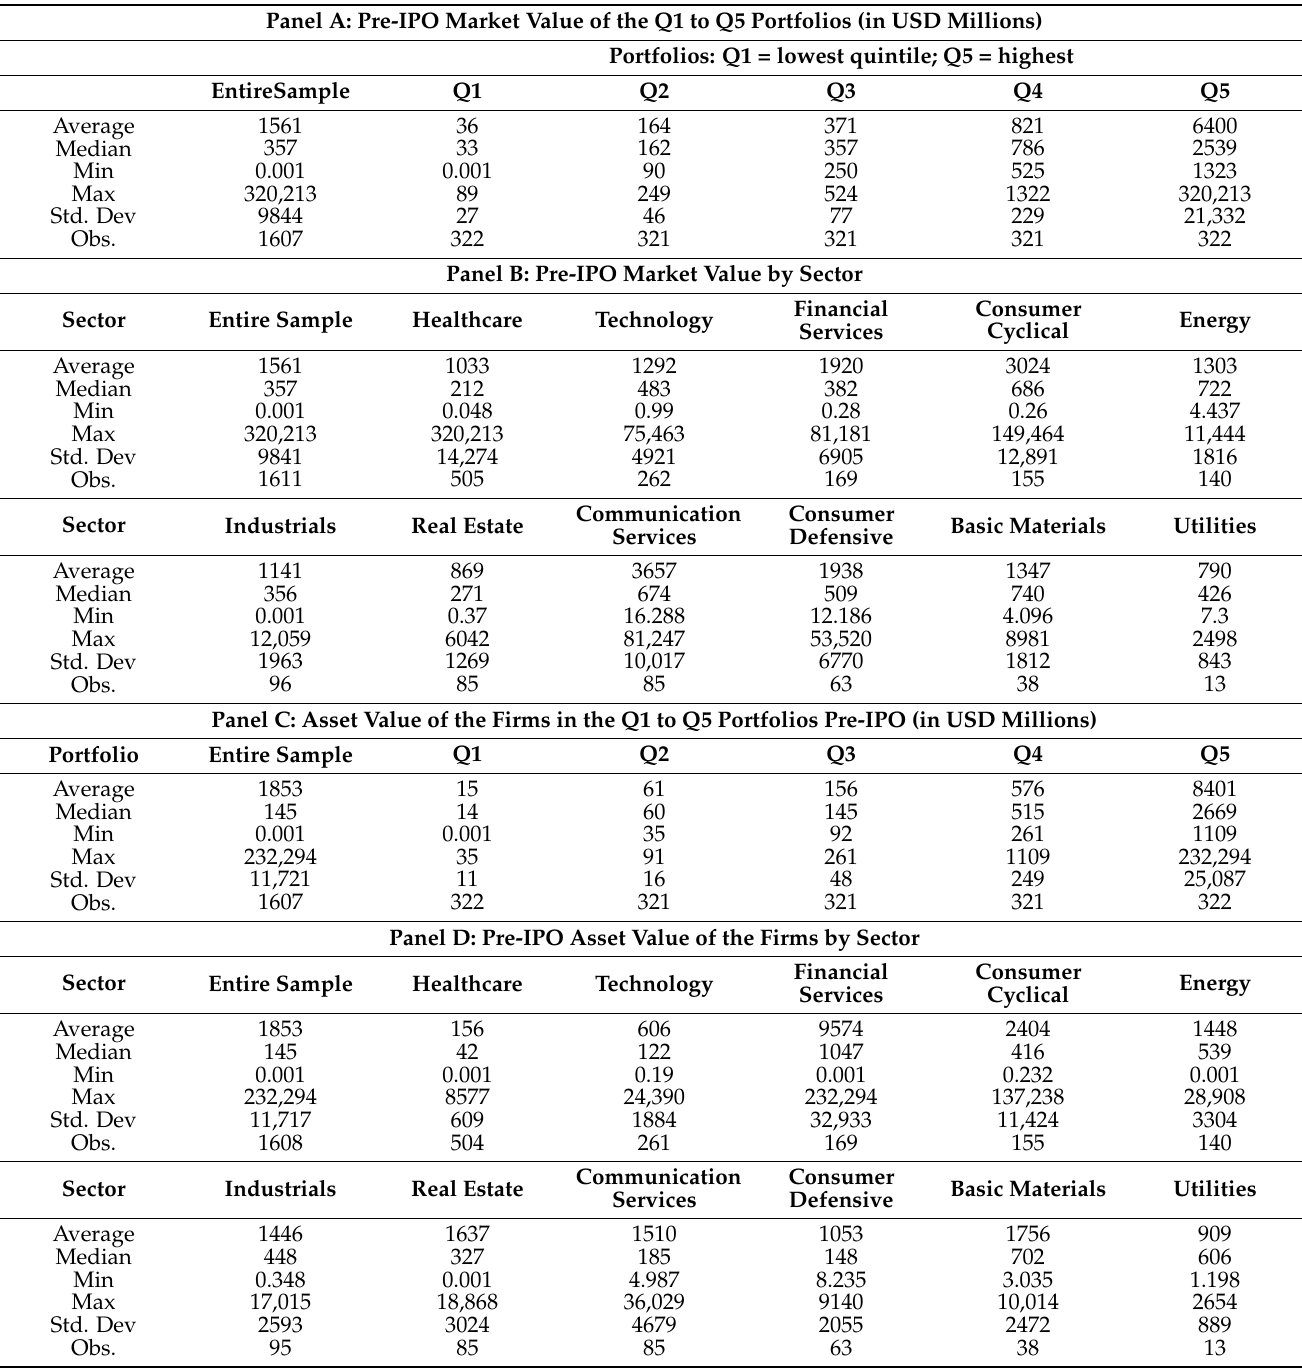
Table 1. Sample Descriptive